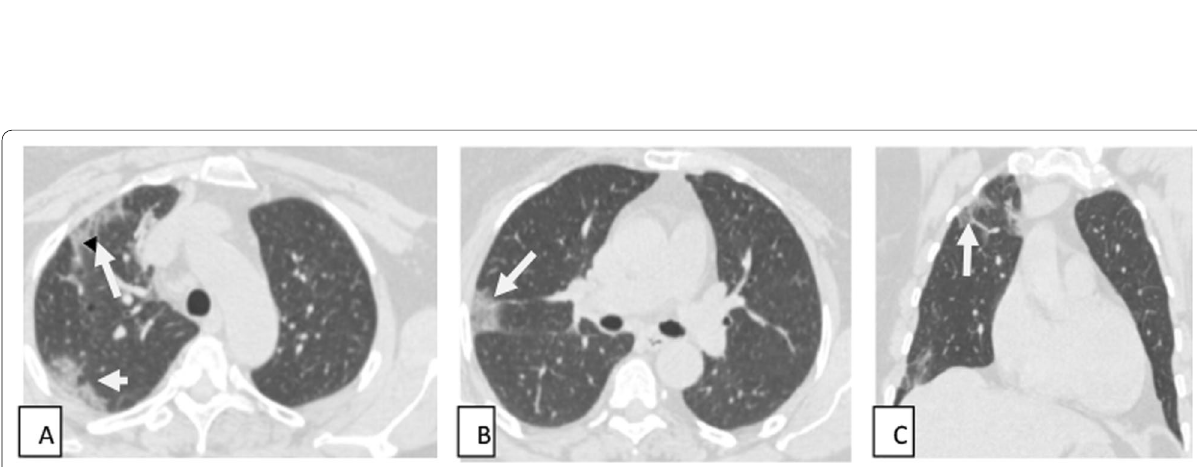
Fig. 2 Male patient aged 56 years presented by loss of smell and taste with low‑grade fever. Axial ( A , B ) and coronal ( C ) CT cuts show bilateral multifocal ground‑glass opacities, and smaller areas of consolidation and areas of interstitial thickening giving crazy‑paving appearance (white arrows) are seen involving both lung fields with peripheral/subpleural predominance (mild to moderate severity)